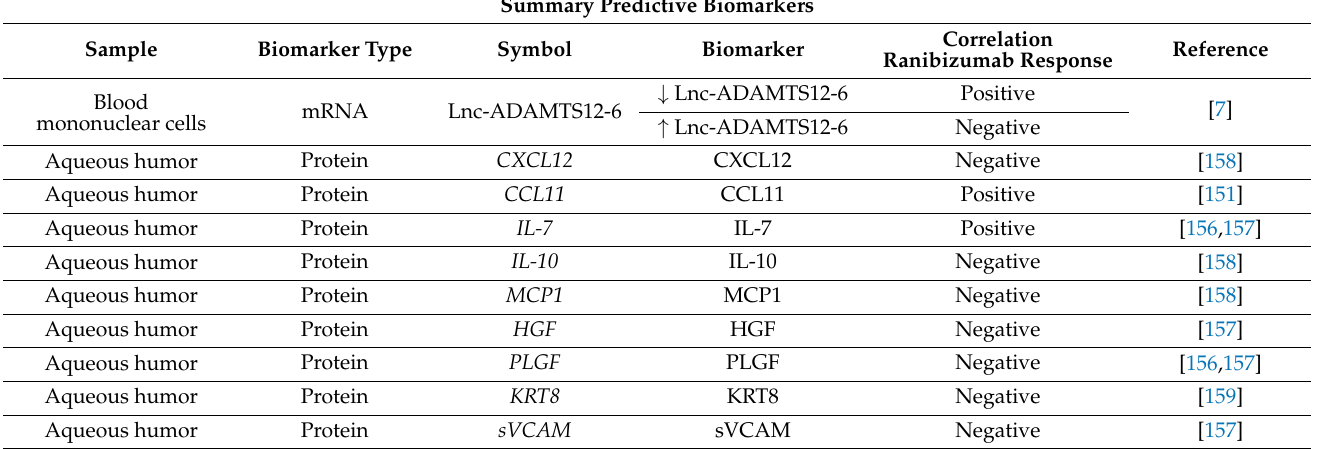
Table 2. Cont. Summary Predictive